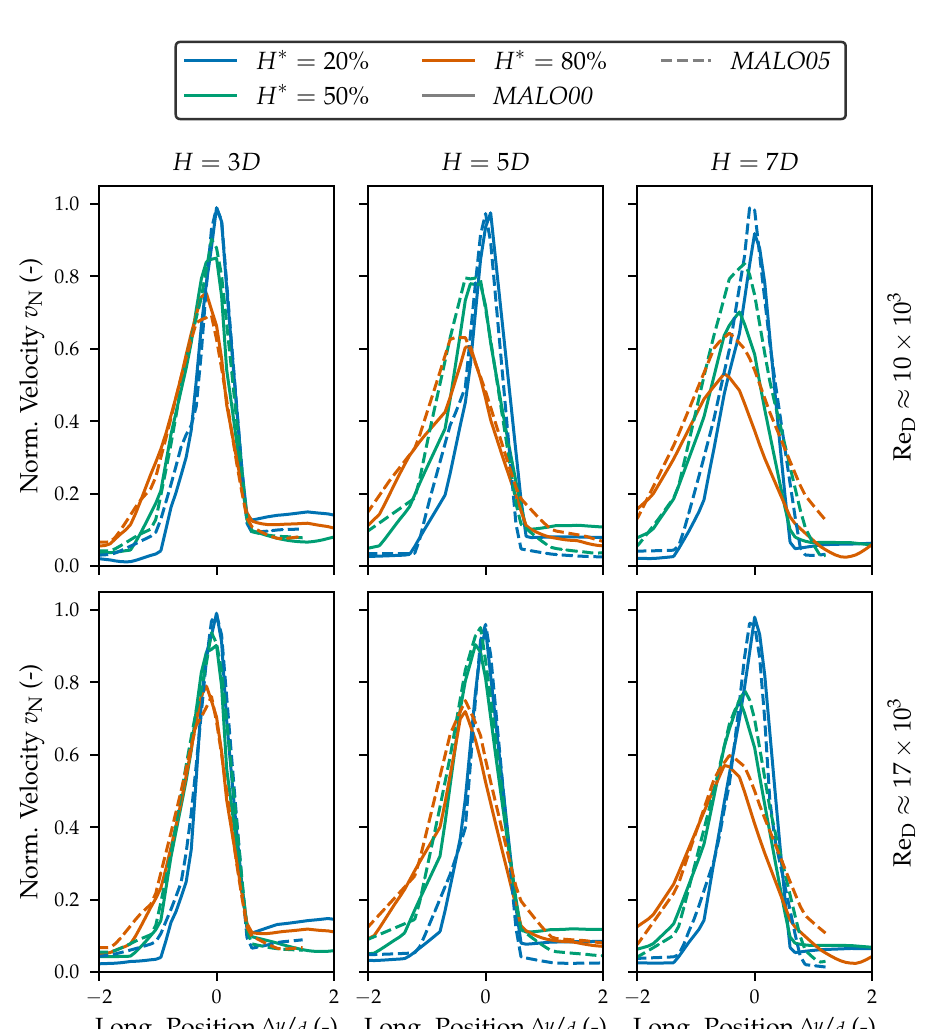
Figure A1. Jet profiles for all configurations tested. Profiles show normalized velocity at three different height (colors) for both alignments (line style) at both Reynolds numbers (rows) and different cavity heights (columns). Velocities taken at x -normal planes. Misaligned cases shifted longitudinally for